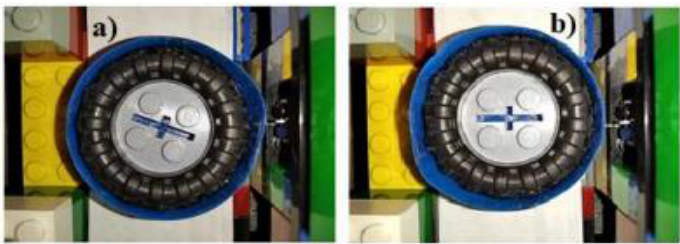
Figure 7. Adjusting the brightness: ( a ) darkening, ( b ) lightening.